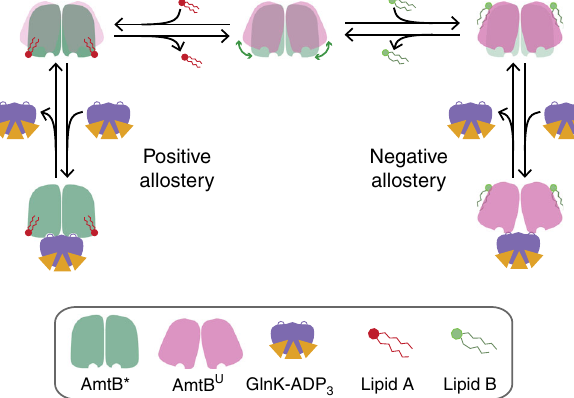
Fig. 5 A plausible model for the allosteric modulation of the AmtB – Glnk by individual lipid-binding events. AmtB interconverts between two conformations (middle). Binding of speci fi c lipids may stabilize either conformation. Those that stabilize AmtB*, the state that resembles when bound to GlnK, will lead to positive allosteric modulation. In contrast, lipids that preferentially stabilize AmtB U , the state that represents the uncomplexed conformation, will lead to reduced binding af fi nity to GlnK or negative